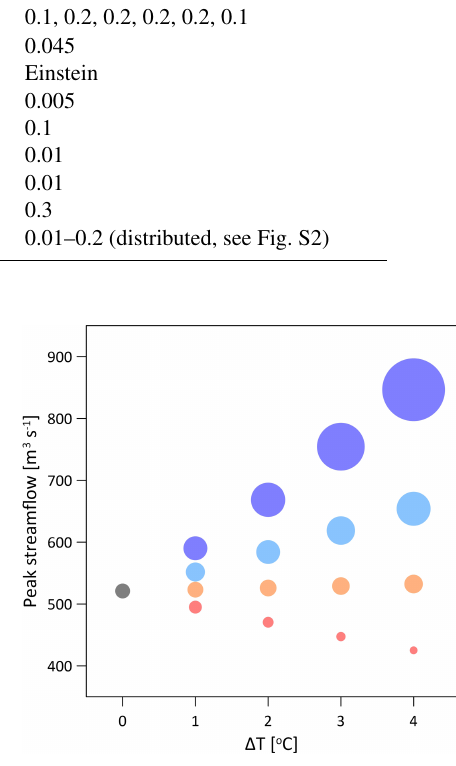
Figure 8. Response of the peak streamflow ( y axis) and peak sed- iment yield (symbol size, S max ) at the outlet of the catchment to changes in the rainfall spatial structure with temperature for strati- form rainfall type. Peak rainfall intensity increases by 7% ◦ C − 1 for all points. Different colours represent a mean areal rainfall inten- sity change: decrease of − 3% ◦ C − 1 (red), not changing (orange), increase of 3% ◦ C − 1 (blue), and increase of 7% ◦ C − 1 (dark blue). Reference (base scenario) for the sensitivity is the single point at (cid:49)T = 0